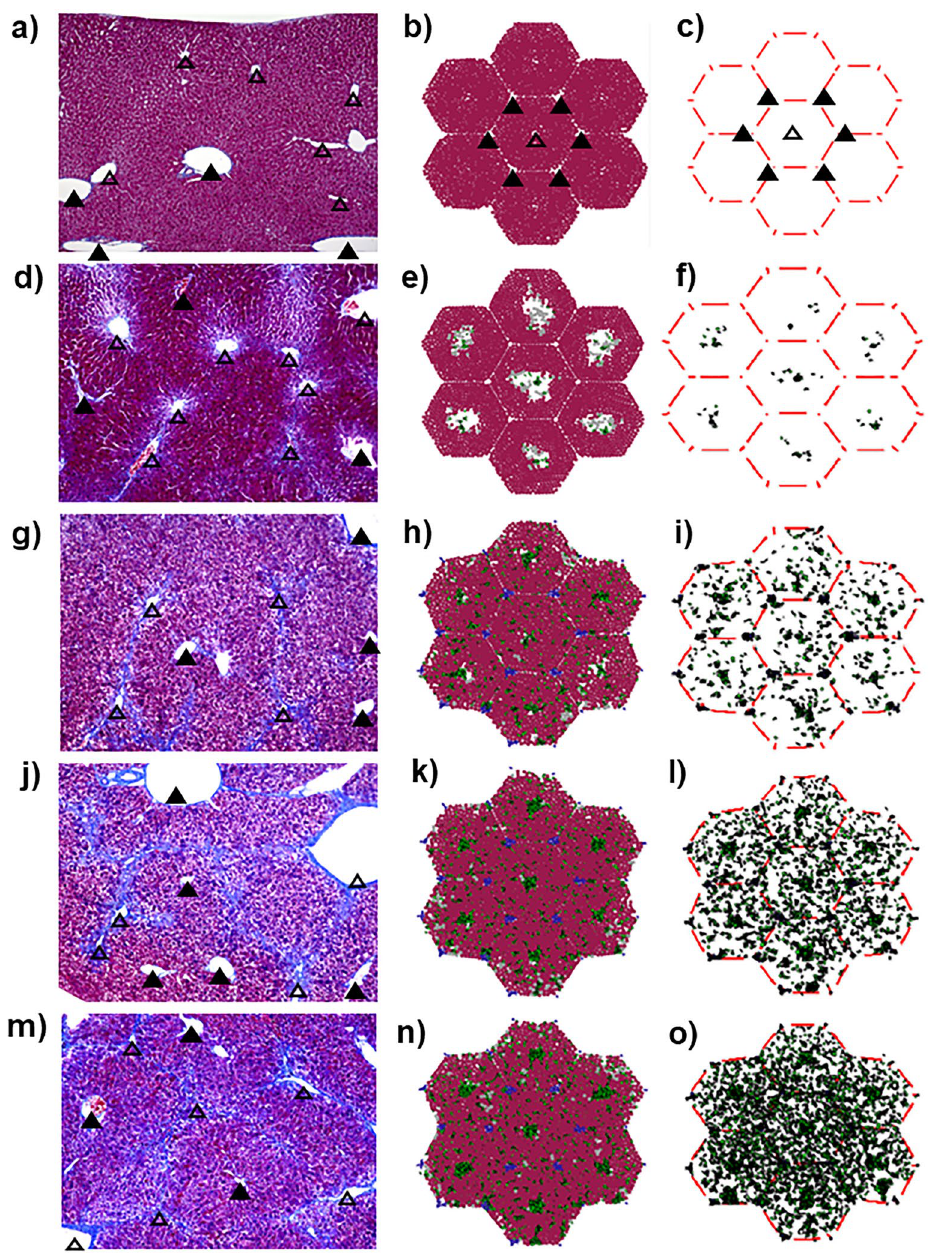
Figure 3. The time-dependent observations of liver lobules. Left panels: experimentally obtained 2-dimensional images of tissue sections ( a , d , g , j , and m ). Centre panels are computationally simulated results ( b , e , h , k , and n ). The right panels also show simulated results without hepatocytes ( c , f , i , l , and o ). The filled and open triangles indicate portal and central veins, respectively. In the simulation results, each agent is shown in different colours; hepatocytes (brown), dead cells (grey), and collagens secreted from myofibroblasts and portal fibroblasts (blue and